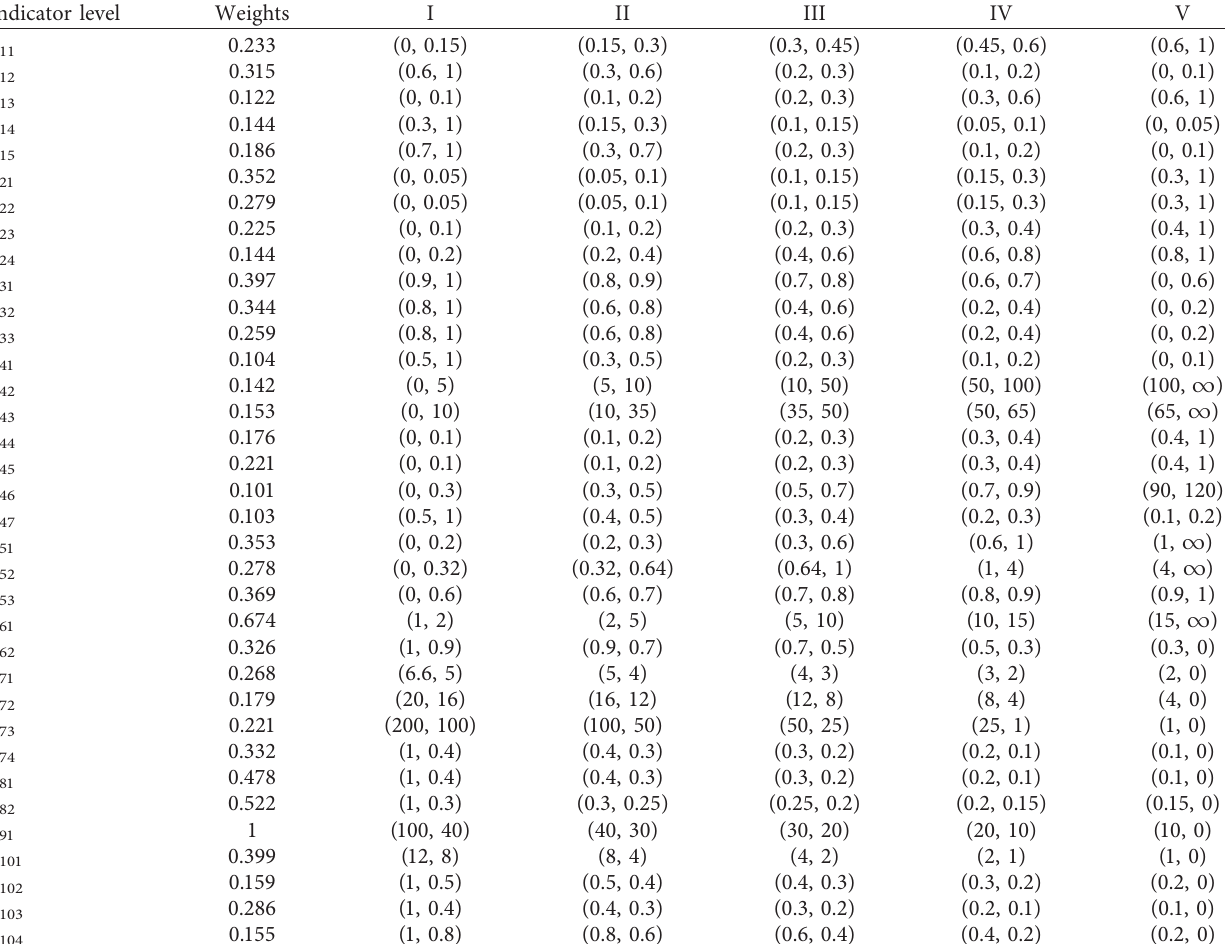
Table 2: Thresholds of vulnerability assessment indicators for reusing old industrial